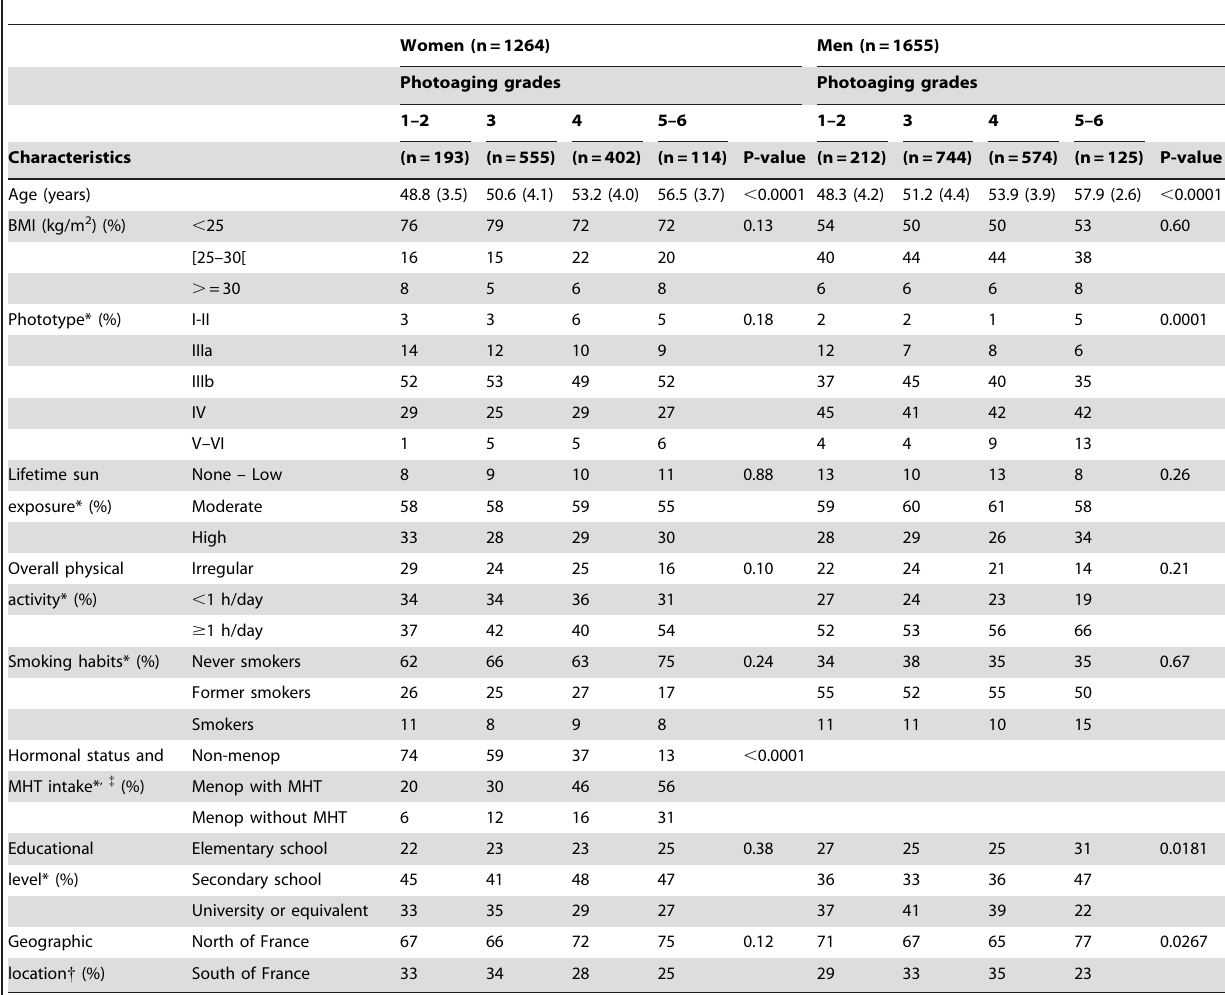
Table 1. Demographic, medical and behavioral characteristics according to photoaging